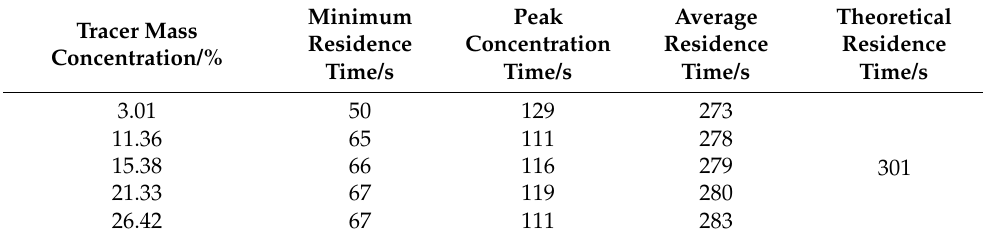
Table 7. RTD curves analysis results in the case of different tracer concentration.